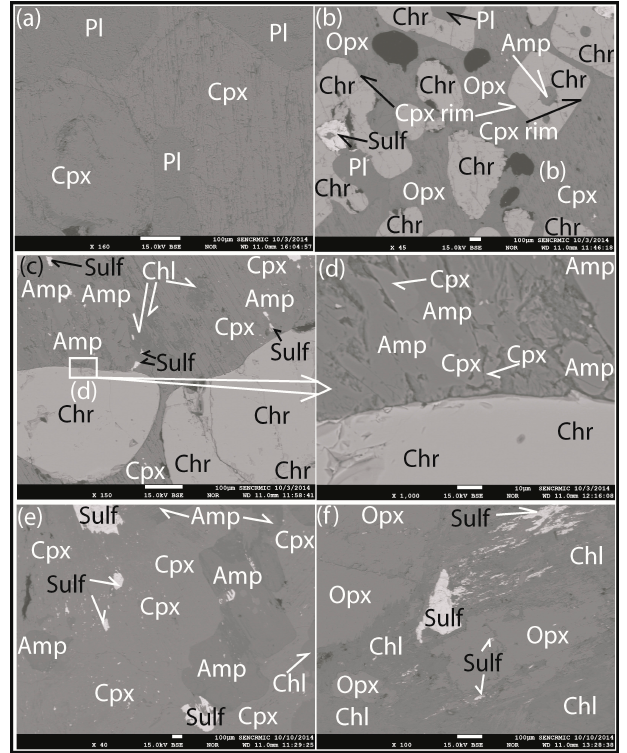
Figure 8. ( a ) Backscattered electron (BSE) image showing plagioclase and clinopyroxene lacking sulfide crystals from the gabbronorite (sample MusGa02) from the Mafic Sequence. ( b – d ) are BSEs from sample MusCr01 within the chromitite stringer at the contact between the Ultramafic and Mafic Sequences. ( b ) Chromite crystals enclosing very fine-grained plagioclase and amphibole crystals and also partially enclose sulfide crystals with plagioclase, clinopyroxene and orthopyroxene being the other crystals. ( c ) Chlorite and amphibole both replacing clinopyroxene. Micron-size sulfide crystals are enclosed in both amphibole and clinopyroxene crystals ( c ). ( d ) Close-up of ( c ) showing amphibole replacing clinopyroxene crystals with very fine-grained inclusions of sulfides in both. ( e ) Amphibole replacing clinopyroxene with numerous very fine-grained sulfide inclusions in both minerals. The relatively coarser-grained sulfides are included only in clinopyroxene (sample MusWebb02a). ( f ) fine- to relatively coarser-grained sulfides occurring as laths within chlorite relatively finer-grained sulfide amounts occurring within orthopyroxene crystals (sample